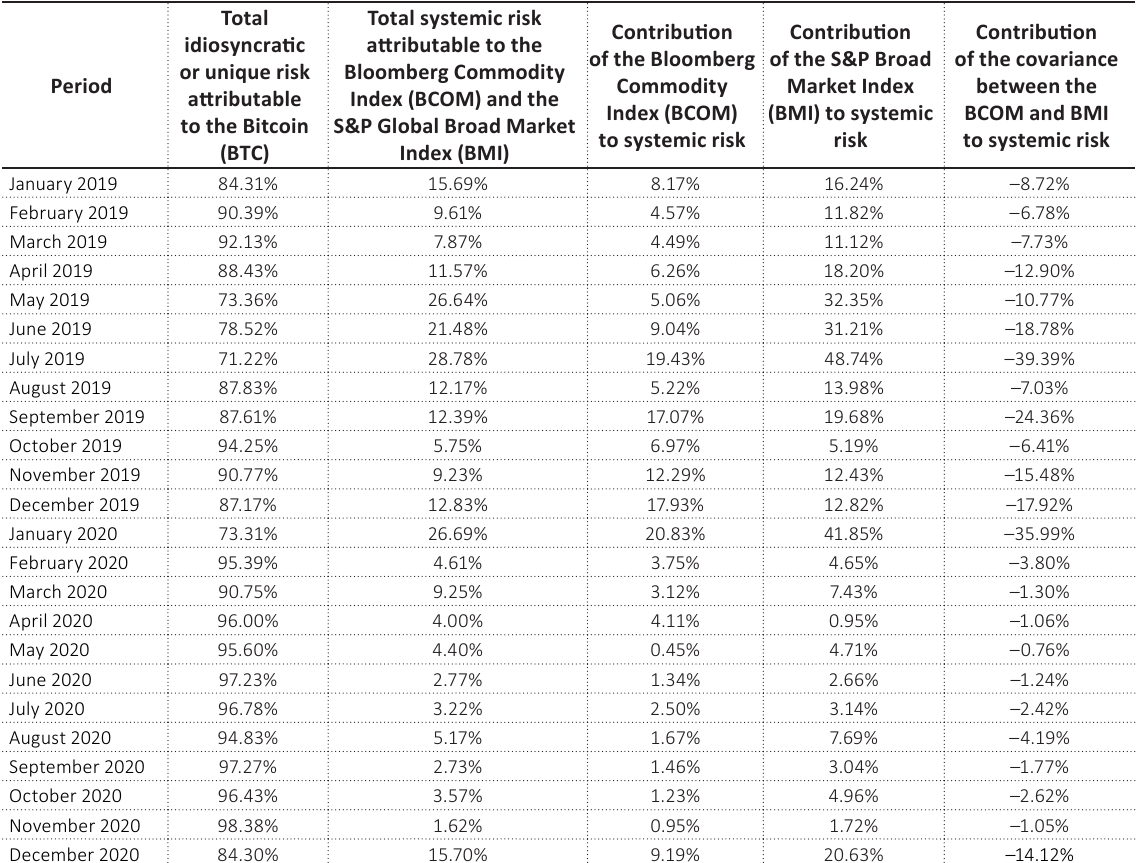
Table 3. Monthly average of unique and systemic risk of the Bitcoin attributable to shocks from the Bloomberg Commodity Index and the S&P Global Broad Market Index